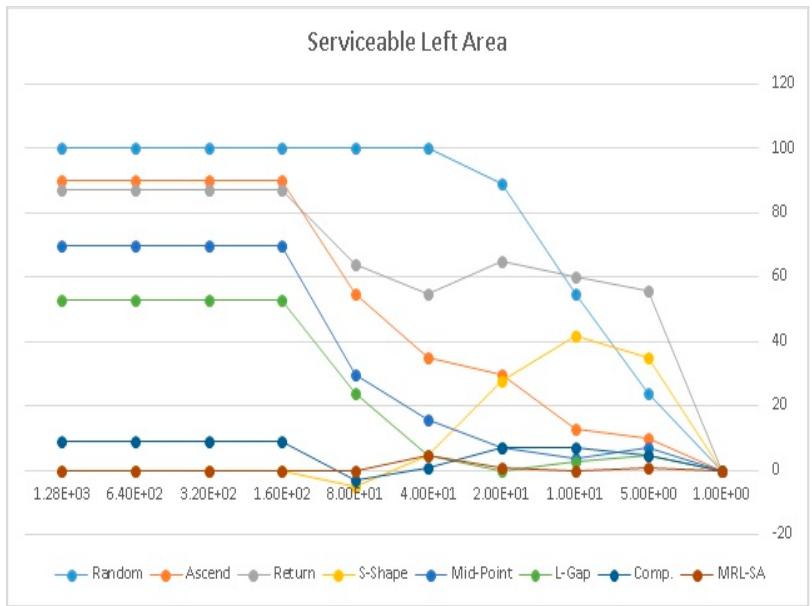
Figure 9. Comparison under left area classification.